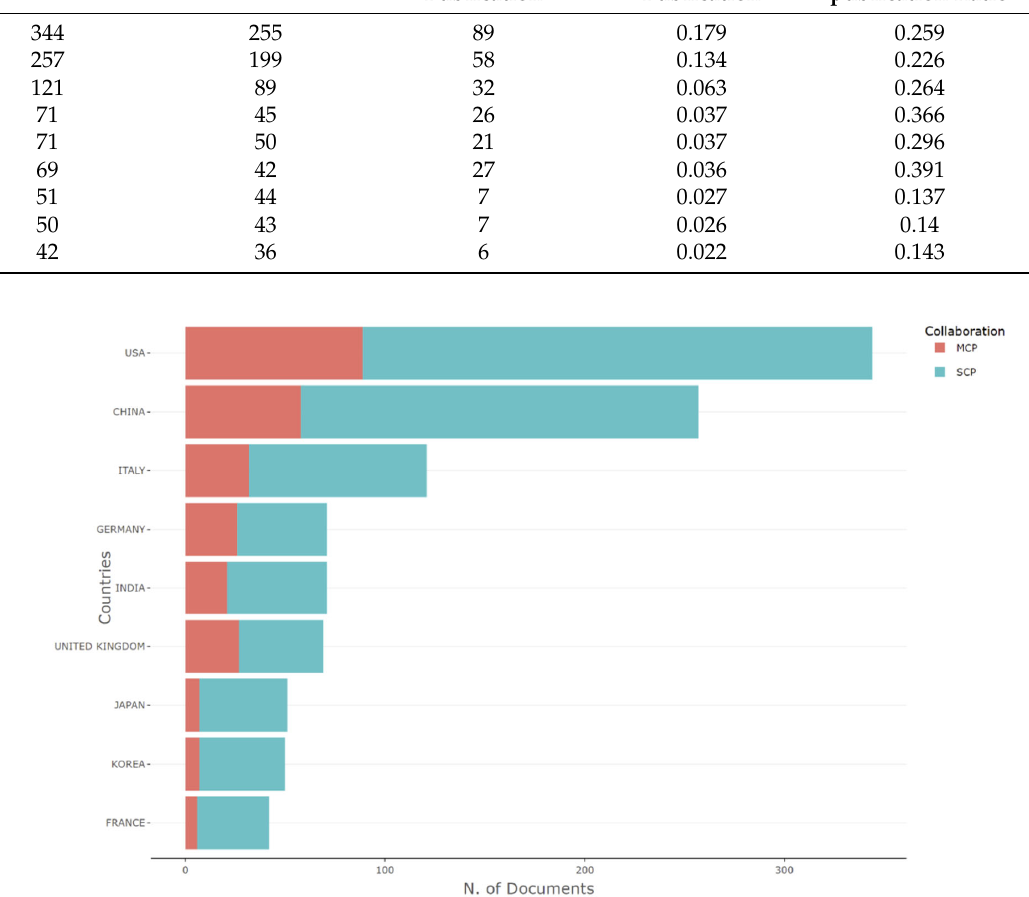
Figure 7. Corresponding authors’ countries representing inter ‐ country (MCP) collaboration and intra ‐ country (SCP) collaboration.